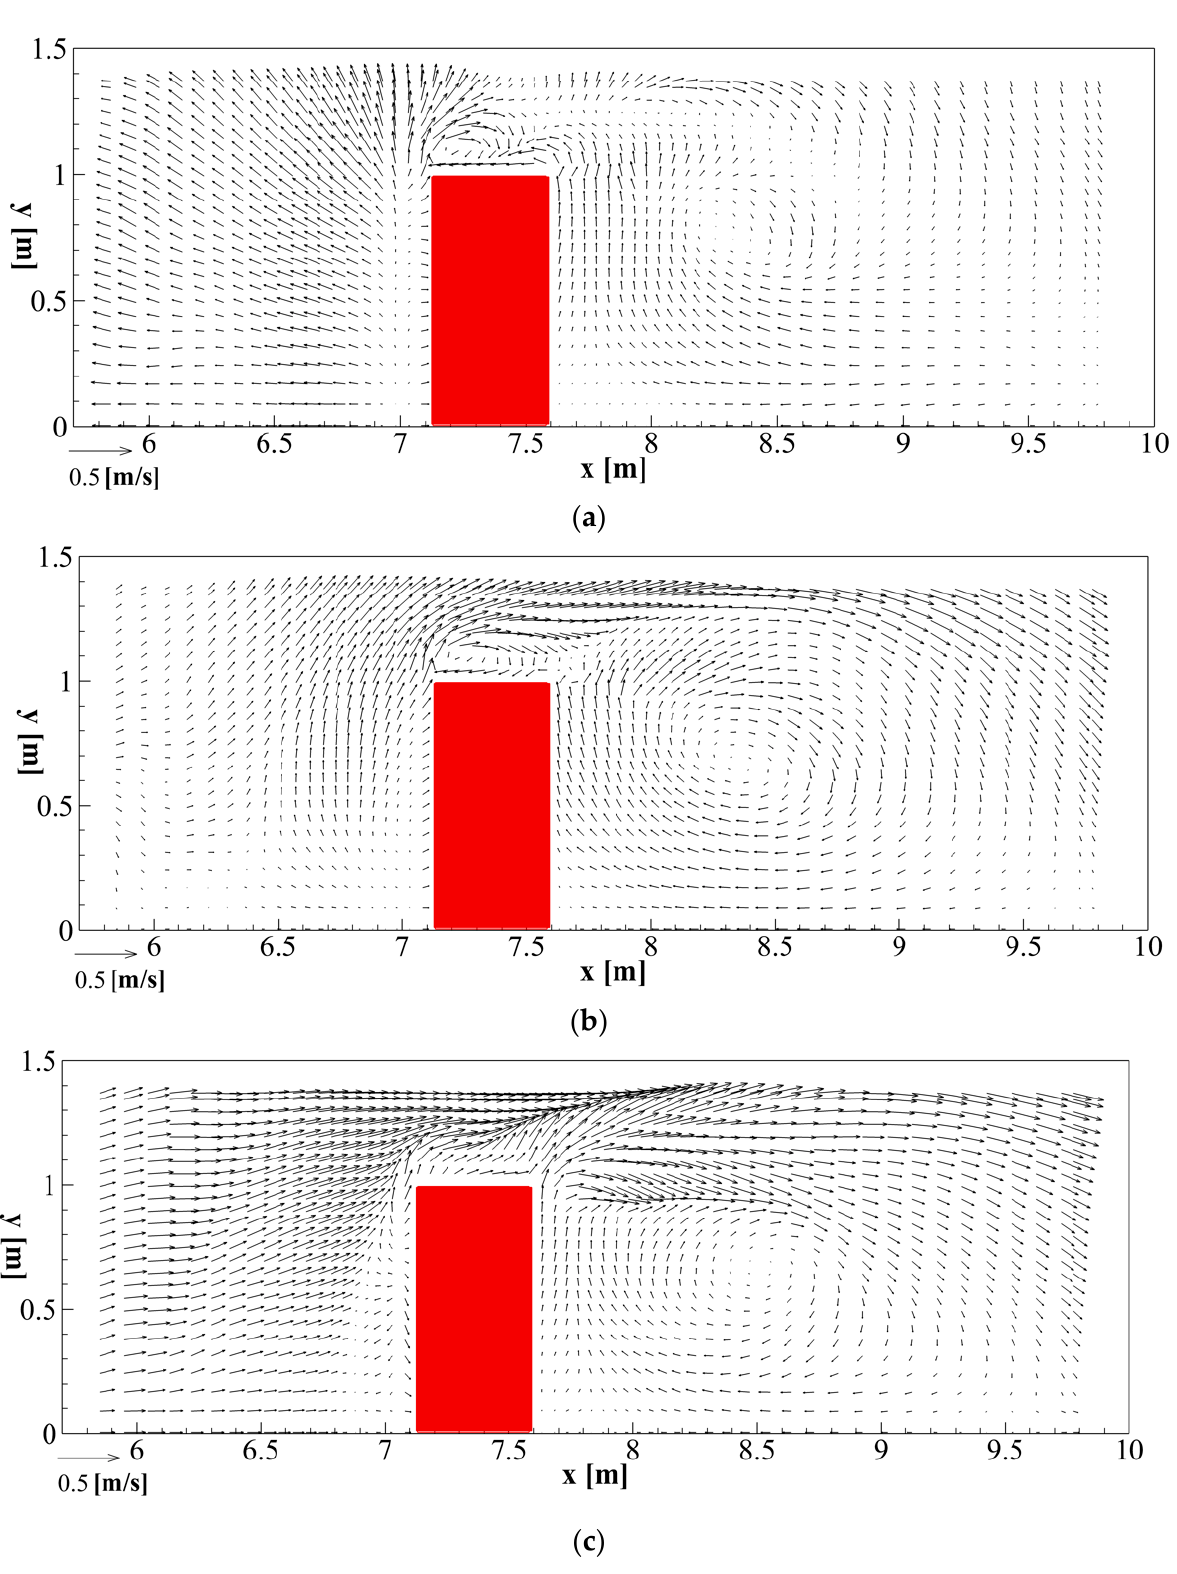
Figure 16. Wave–structure interaction. Circulation patterns. ( a ) Near the bottom. ( b ) At an intermediate water depth. ( c ) Near the free surface.